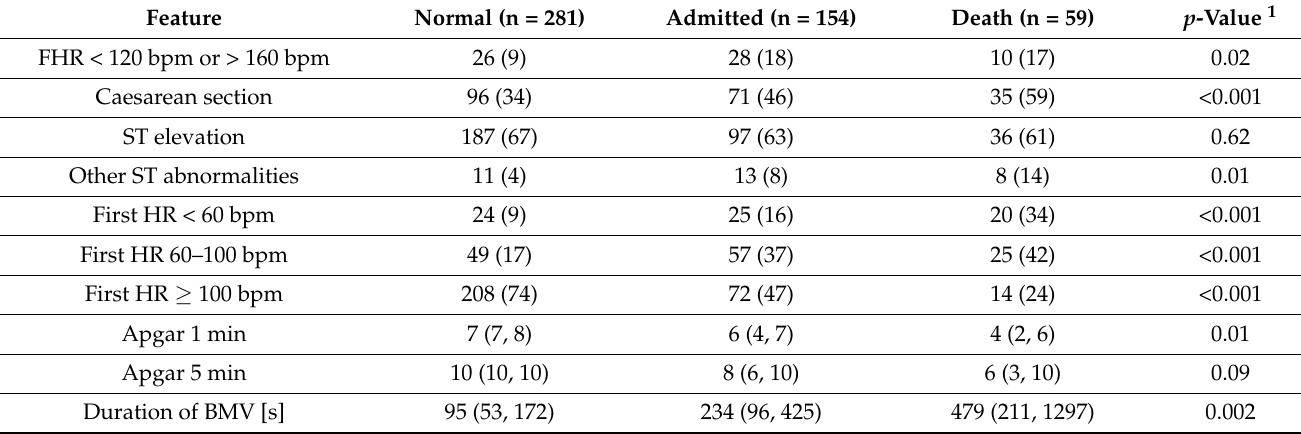
Table 2. Characteristics of 494 infants with three